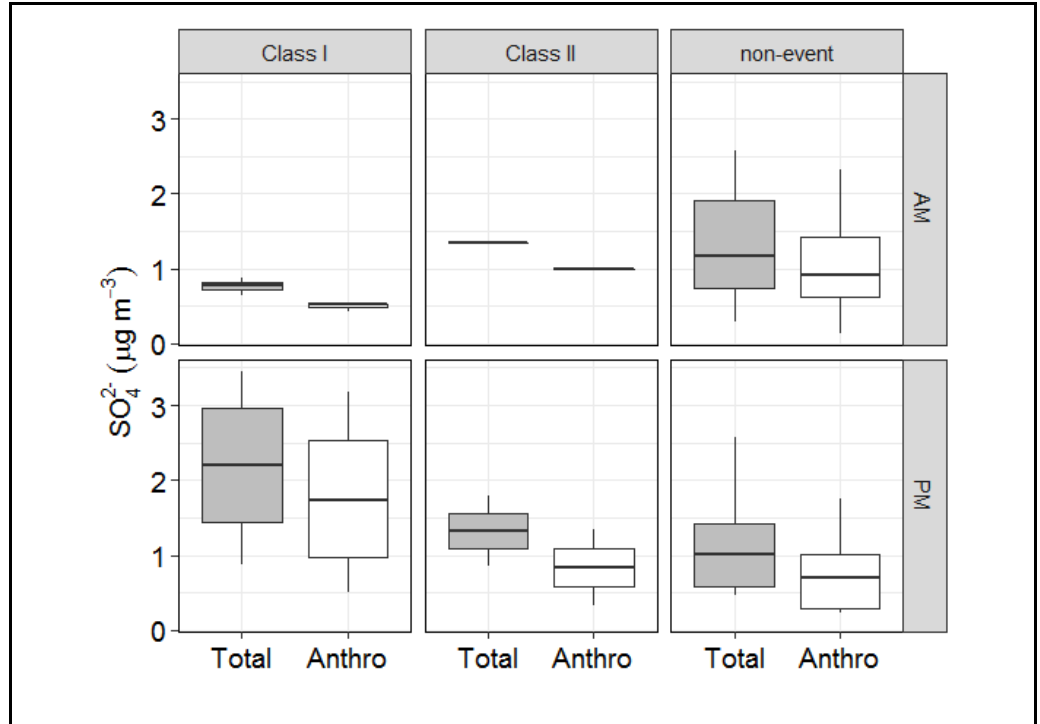
Figure 3. Box plot of total (“Total”) and anthropogenically- (“Anthro”) derived SO 2 − days (22 January, 6 February, 7 February and 8 February 2013, number of samples = 14), Class II event days (29 January and 9 February 2013, number of samples = 6) and on non-event days (number of samples = 64). “AM” and “PM” refer to measurements from 4:00–9:00 and 10:00–18:00, respectively. The central line of each box is the median. The lower and upper edges of each box are the 25% quartile and 75% quartile, respectively. Whiskers are extended to the smallest of either the furthest data point or 1.5-times the quartile